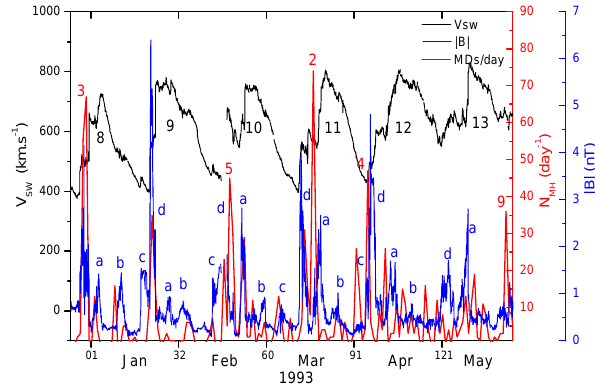
Fig. 5. The solar wind speed for six reappearances of a major high speed solar wind stream (listed as events 8 to 13), the magnetic field magnitude and the number of MDs/day. Although there is one major solar wind stream, there are several minor ones that lead to CIRs a, b and